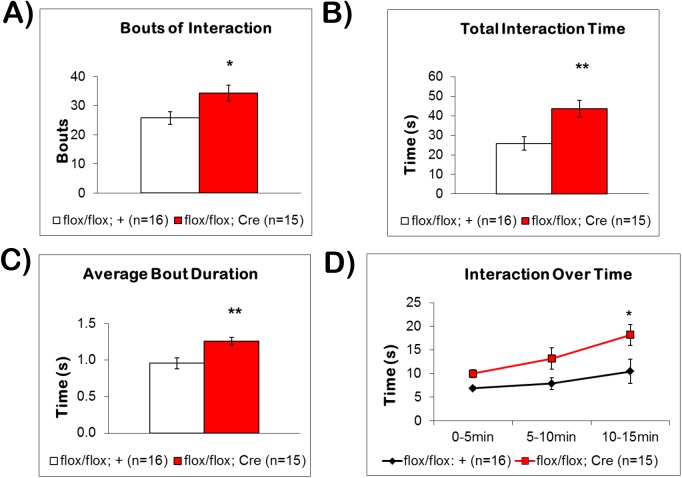
Loss of BMPRII Affects Object Exploratory Behavior.(A) The fbΔBMPRII mutant mice had significantly more bouts of exploring the novel object than control littermates. (B) When the total interaction time over the 15-minute trial was examined, fbΔBMPRII mutant mice spent significantly more time interacting with the novel object than control littermates. (C) When the duration of individual bouts was analyzed, fbΔBMPRII mutants had significantly longer bouts of interaction compared to control littermates. (D) When interaction behavior was analyzed over time in 5-minute bins, fbΔBMPRII mutants spent significantly more time exploring the novel object, compared to control littermates (F(1,29) = 8.91, p = 0.0057).Thus, fbΔBMPRII mutants show greater interest in object exploration than control littermates. Results reported as mean ± S.E.M. Asterisk indicates *p<0.05 or **p<0.005.